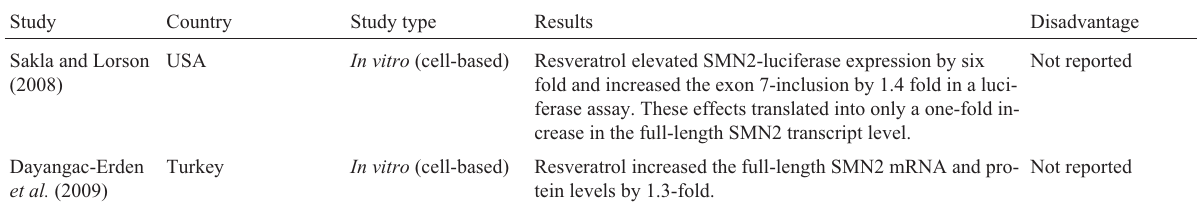
Table 10 - Summary of studies on resveratrol for the treatment of spinal muscular